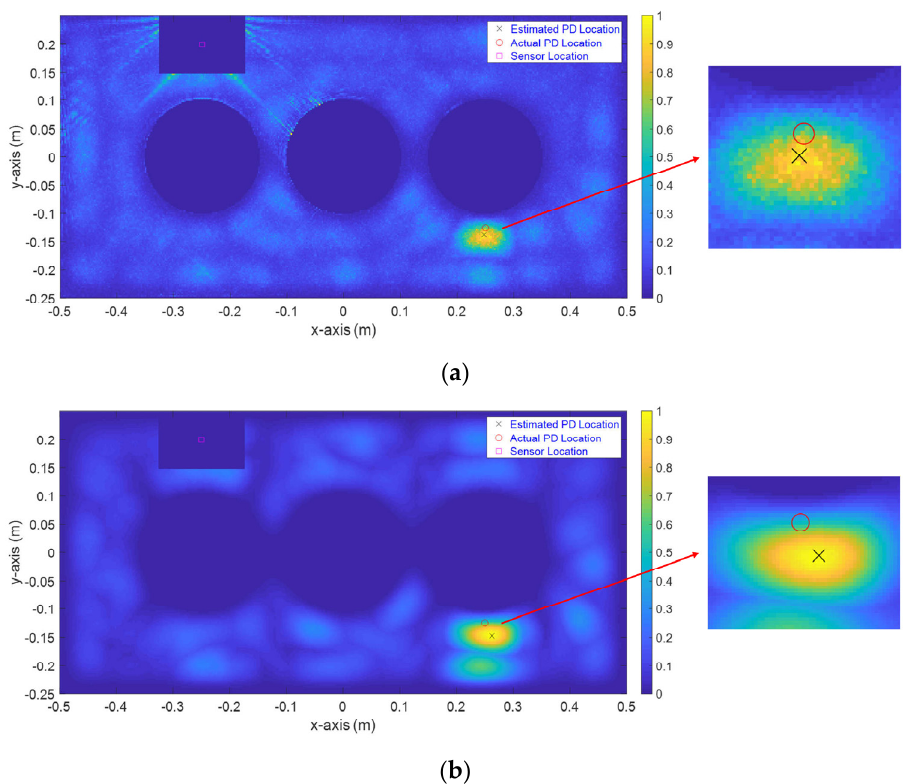
Figure 8. The distribution of normalized maximum electric field power over the complete simulation time interval on the computational domain, ( a ) obtained by the EMIF method with a 12.7 mm localization error and ( b ) obtained by the EMTR method with a 25.7 mm localization error. The localization errors for the proposed EMIF method and EMTR are 12.7 mm and 25.7 mm, respectively. Again, the EMIF method shows a better performance compared to the classical EMTR method. The lengths of the square mask windows used in both the EMIF and EMTR methods are 30 and 20 cells along the x- and y-axes, respectively